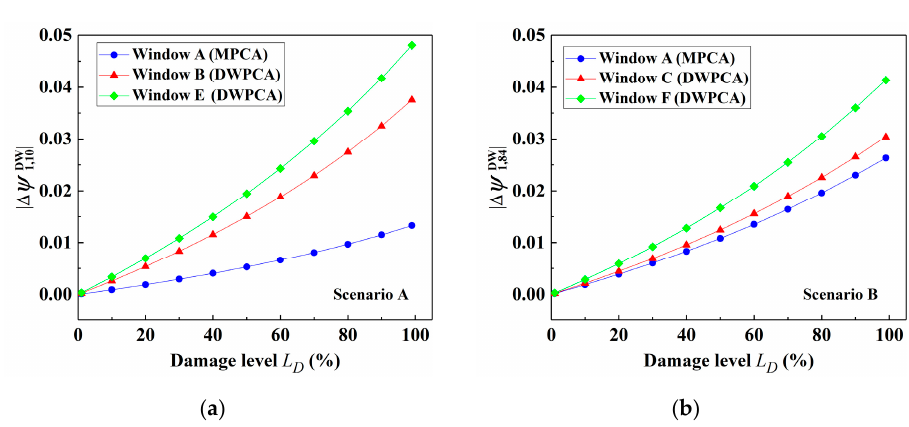
Figure 19. Variation of the absolute value of the CEVs with damage level by MPCA and DWPCA: ( a ) Scenario A; ( b ) Scenario B. ( a ) Scenario A; ( b ) Scenario